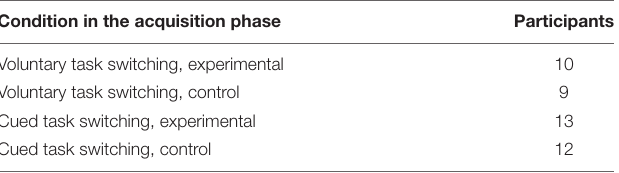
TABLE 1 | Distribution of participants in Experiment 1 in each condition after